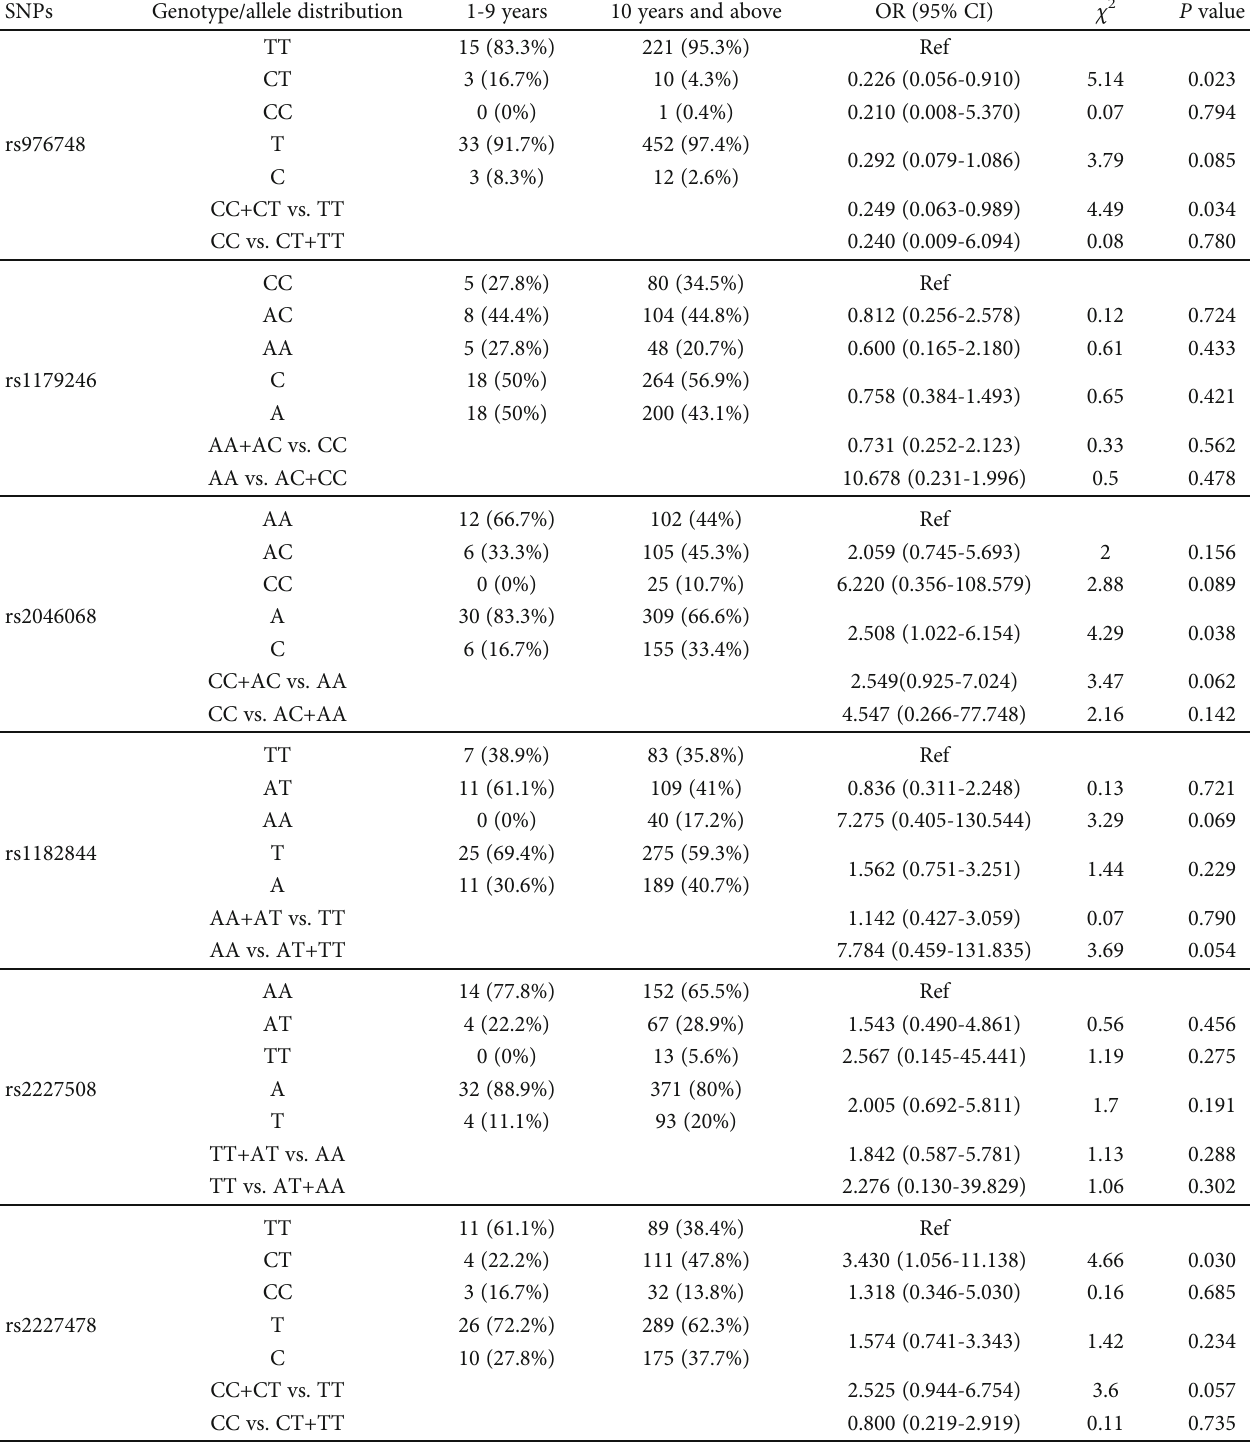
Table 4: Genotype distribution and allele frequency of IL-22 SNPs in group 1-9years of age compared to 10 years and above age